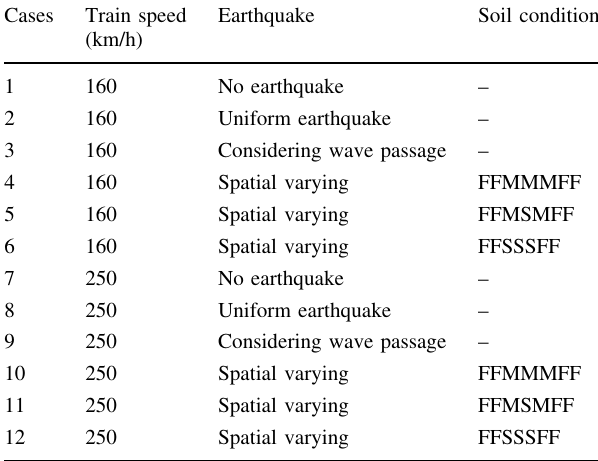
Table 3 Information about